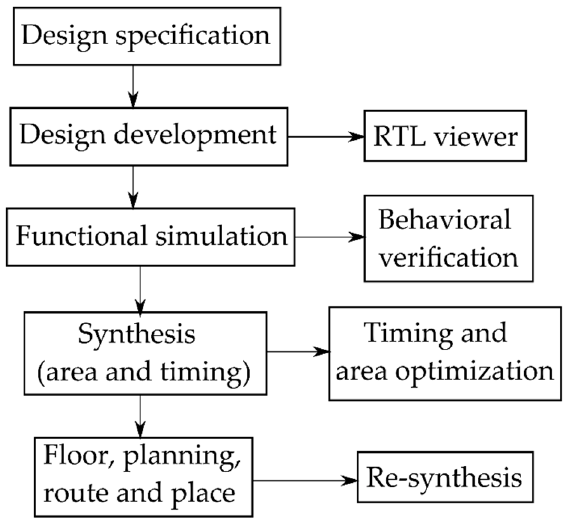
Figure 7. Design Figure 7. Design flow.